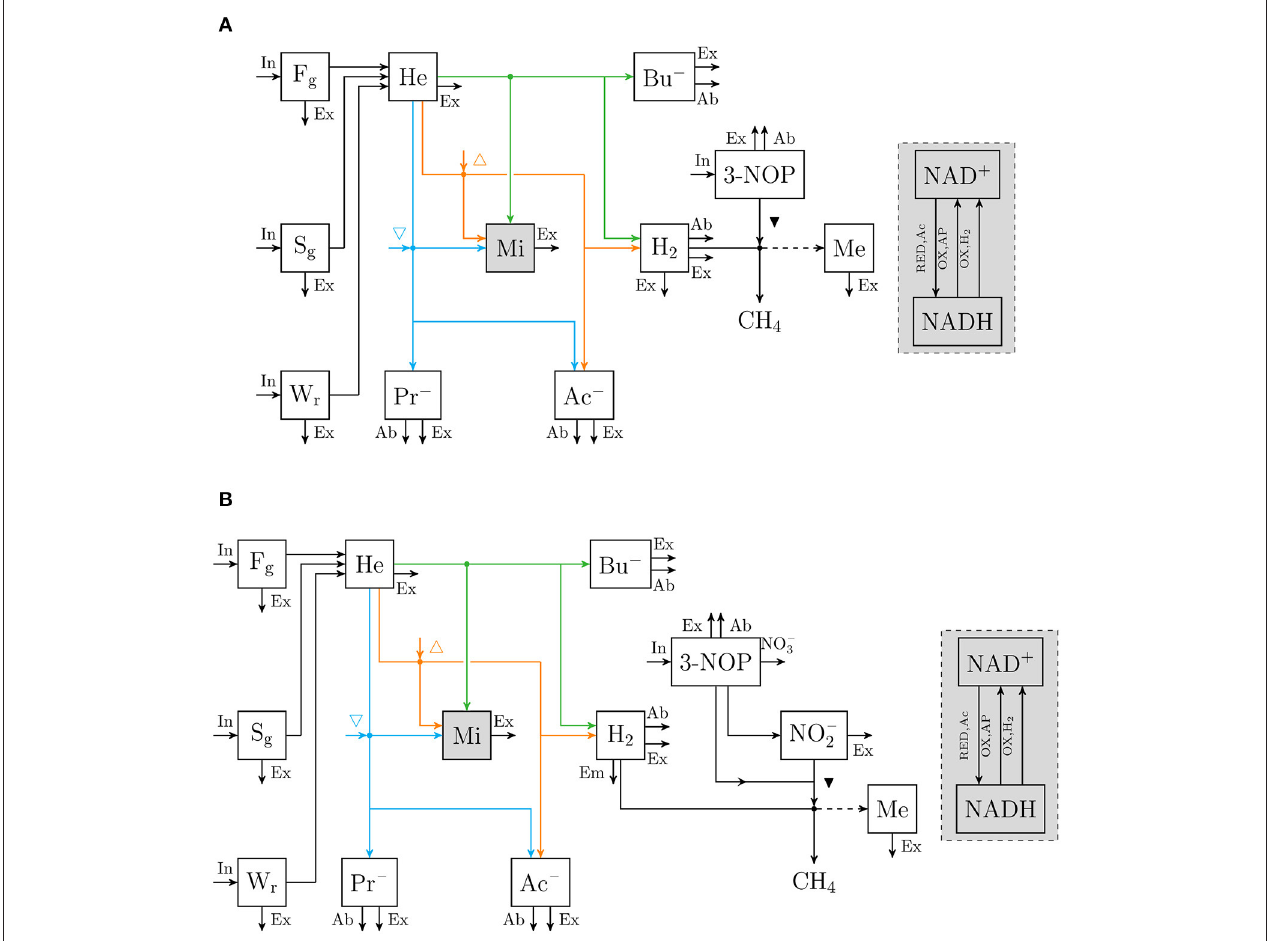
FIGURE 1 | Flow chart that conceptually represent (A) the rumen 3-nitrooxypropanol simple model, and (B) the rumen 3-nitrooxypropanol+nitrite model. Boxes enclosed by solid lines represent state variables (with F g for degradable fiber [g], S g for degradable starch [g], W r for soluble carbohydrates [g], He for hexose [mol], Mi for fermentative microbes [g], Ac – for acetate [mol], Pr – for propionate [mol], Bu – for butyrate [mol], H 2 for hydrogen [mol], 3-NOP for 3-nitrooxypropanol [mol], NO – 2 for nitrite [mol], Me for methanogens [g]. The sum of NAD + and NADH [mol] is a fraction of Mi and a gray fill is used to visualize this), arrows represent fluxes with the dashed arrow indicating H 2 is not incorporated but its conversion to CH 4 is required for growth (with In for dietary input, Ex for fractional exit from the rumen to the lower tract, Ab fractional absorption, Em for fractional emission, NO – 3 for nitrate production, RED, Ac for NAD + reduction associated with hexose converted into 2 Ac, Ac – + 4 Pr – , and {OX,H 2 } for hydrogenase catalyzed NADH oxidation; △ and ▽ indicate that at {OX,AP} for NADH oxidation associated with hexose converted into 2 3 3 increased NAD + to NADH ratio the microbial conversion is promoted and inhibited, respectively; H indicates inhibition of methanogenesis; fluxes may be unique per state variable and are further specified in Van Lingen et al. (2019), dots indicate microbial conversions.